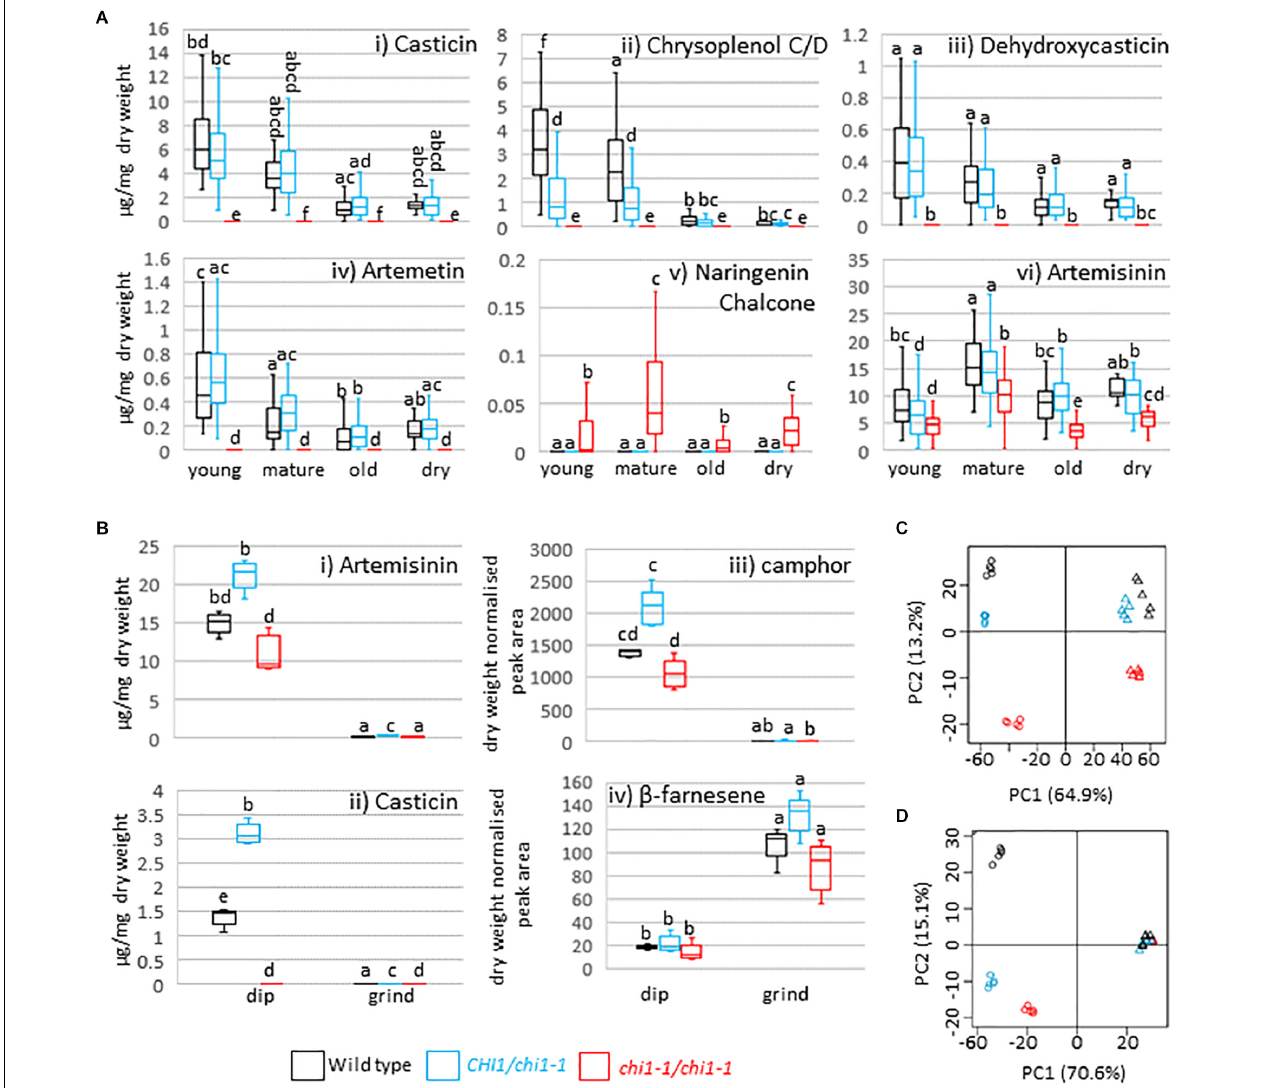
FIGURE 2 | Effects of the chi1-1 mutation on the metabolite profile of Artemisia annua . Box and whisker plots showing levels of (A) four major flavonoids, putative naringenin chalcone and artemisinin as measured by UPLC-MS in young (leaves 1–5 as counted from the apical meristem), mature (leaves 11–13), old (three leaves above first senescing leaf) and dry (oven-dried) leaf material harvested from 12 to 14-week-old plants of the Artemis wild type (black), heterozygous (blue) and homozygous chi1-1 mutant (red) and (B) selected flavonoids, sesquiterpenes and monoterpenes in the extracts from dipped (dip) or ground leaf material for the wild type (black) and heterozygous (blue) and homozygous (red) chi1-1 mutant. Metabolite concentrations measured by GC- or UPLC-MS (A,B) are expressed as a proportion of the residual dry leaf material following extraction. Groups not sharing letters representing Tukey’s range test results indicate statistically significant differences ( p < 0.05). Each box is represented by minimum of 20 (A) or by five (B) biological replicates. (C,D) Principal component analysis of 83 UPLC-MS identified peaks (C) and of 58 GC-MS identified peaks (D) from dipped and ground leaf material from wild type (black) and heterozygous (blue) and homozygous chi1-1 (red). Dip leaf extracts are represented by circles and ground leaf extracts by triangles. Principal component analysis was performed on log-scaled and mean-centered